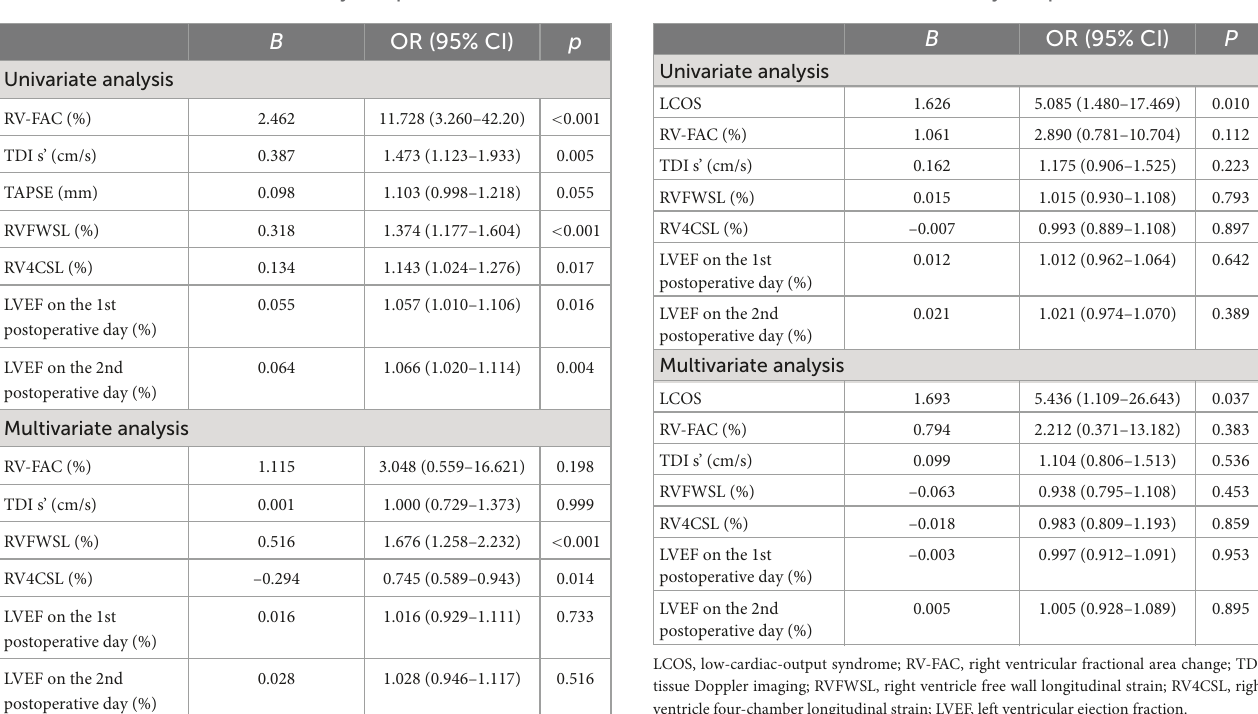
TABLE 6 Univariate and multivariate analysis to predict